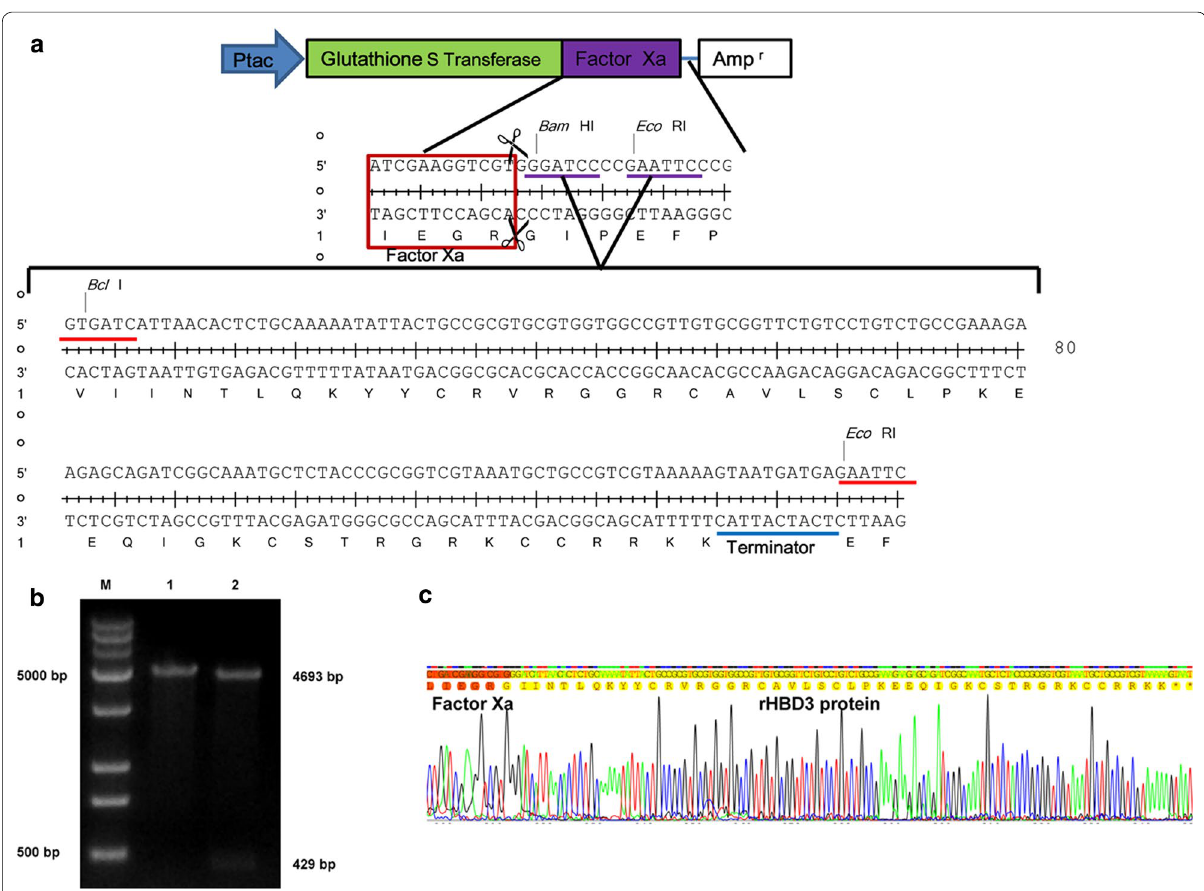
Fig. 1 Recombinant HBD3 protein prokaryotic expression vector construction and verification. a Designing scheme of rHBD3 prokaryotic expres- sion vector. b Restriction enzyme analysis of the PGEX-5X-HBD3 recombinant plasmid. Lane 1 is the DNA fragment recombination plasmid digested by Eco RI. Lane 2 is the DNA fragments of recombination plasmid digested by Bst BI and Eco RI. c Sequencing identification of PGEX-5X-HBD3 vector. The DNA and amino acid fragments marked by red are the Factor Xa recognition sites. The yellow one is the HBD3 protein